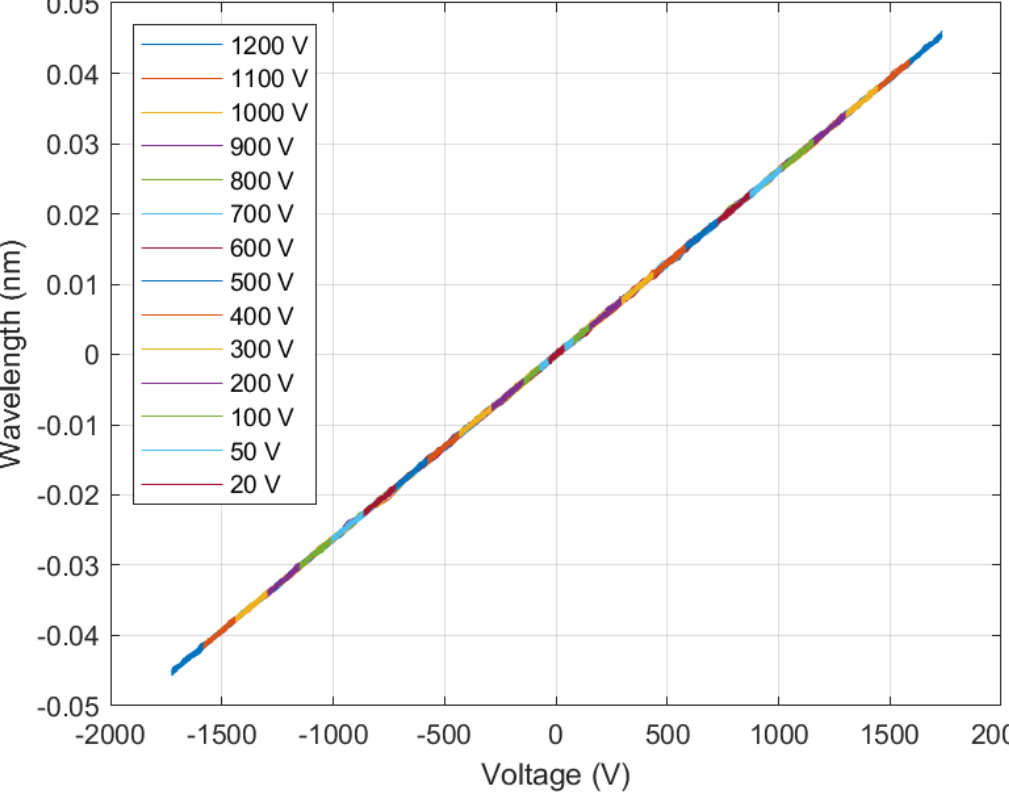
Figure 6. MVT hysteresis. There is no hysteresis between the wavelength and the reference voltage (within the experimental error).